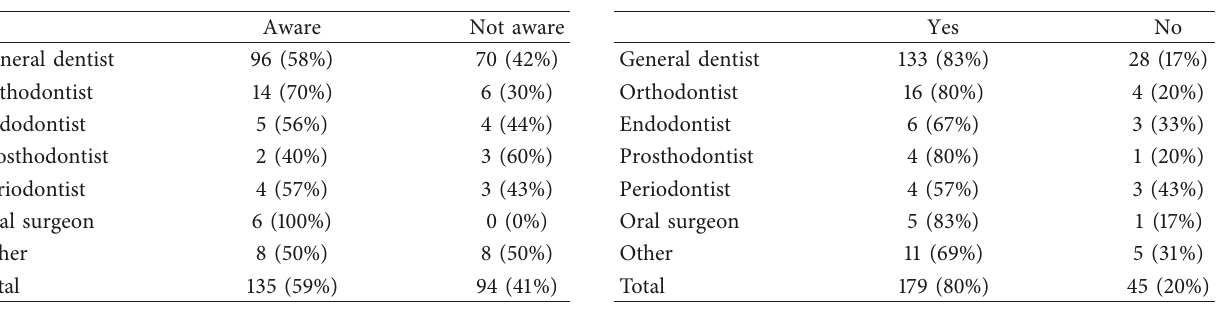
Table 3: Dentists’ awareness about physical therapy treatment for TMD by dentist specialty.